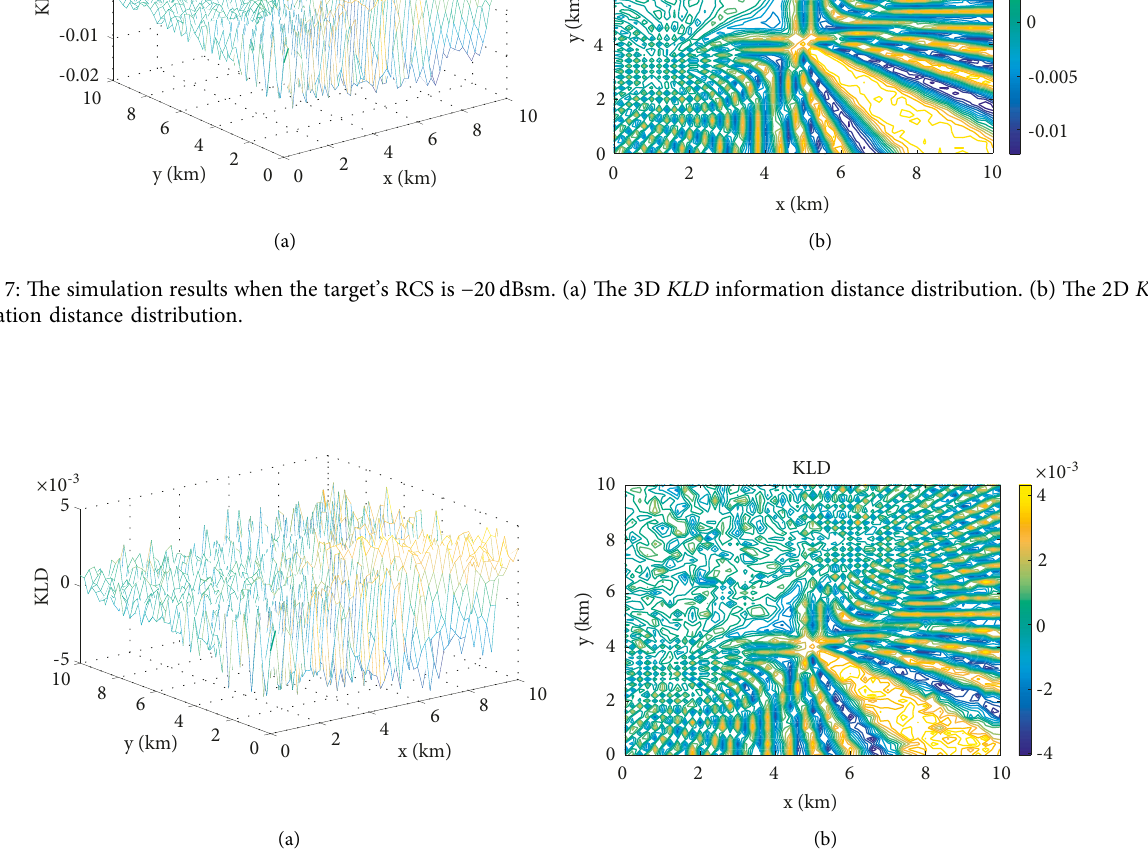
Figure 8: The simulation results when the target’s RCS is − 26dBsm. (a) The 3D KLD information distance distribution. (b) The 2D KLD information distance